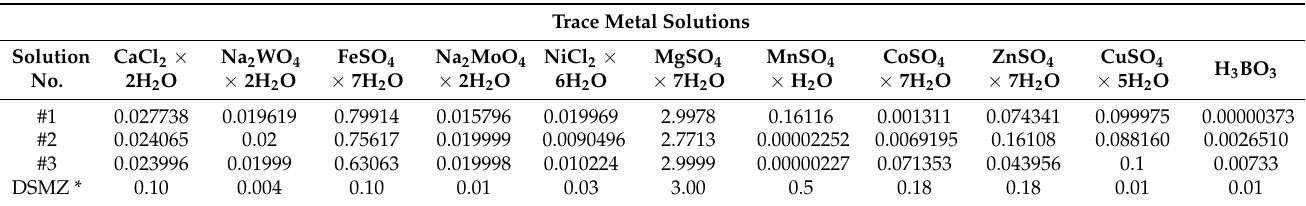
Table 4. The optimal combination of trace element (g/L) for ethanol production by Clostridium ljungdahlii present in stock solution as determined using the statistical method. Trace Metal Solutions